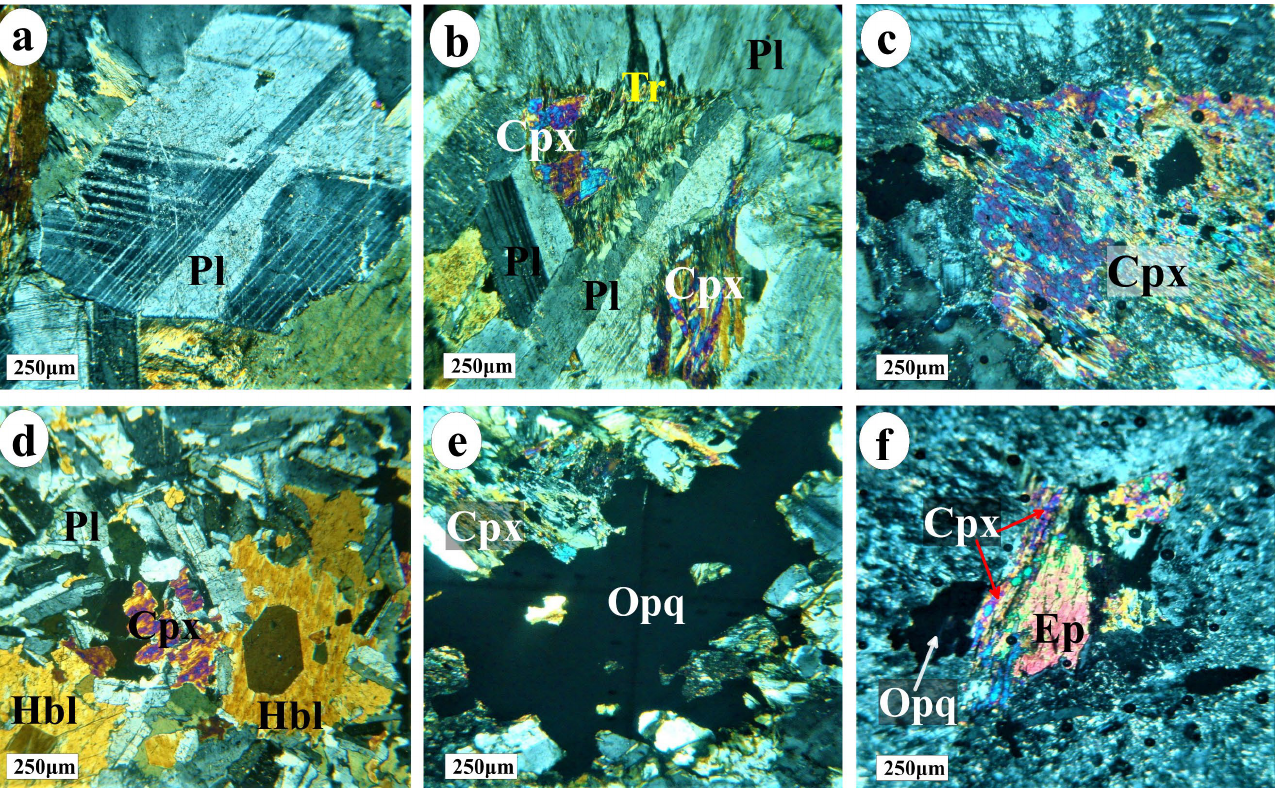
Figure 5. Petrographic characteristics under cross-polarized (XPL) analysis of Abu Ghalaga. ( a ) Percline twinning of plagioclase (Pl). ( b ) Sub-ophitic texture showing clinopyroxene (Cpx) altered to tremolite (Tr) and Carlsbad twinning of plagioclase (Pl). ( c ) Well-developed crystal of clinopyroxene (Cpx) with small spot of opaque minerals (Opq). ( d ) Hornblende (Hb) after clinopyroxene (Cpx). ( e ) Fe-Ti oxide (Opq = magnetite/ilmenite) occurs as interstitial mineral between silicate minerals. ( f ) Epidote (Ep) is the alteration product after clinopyroxene (Cpx).